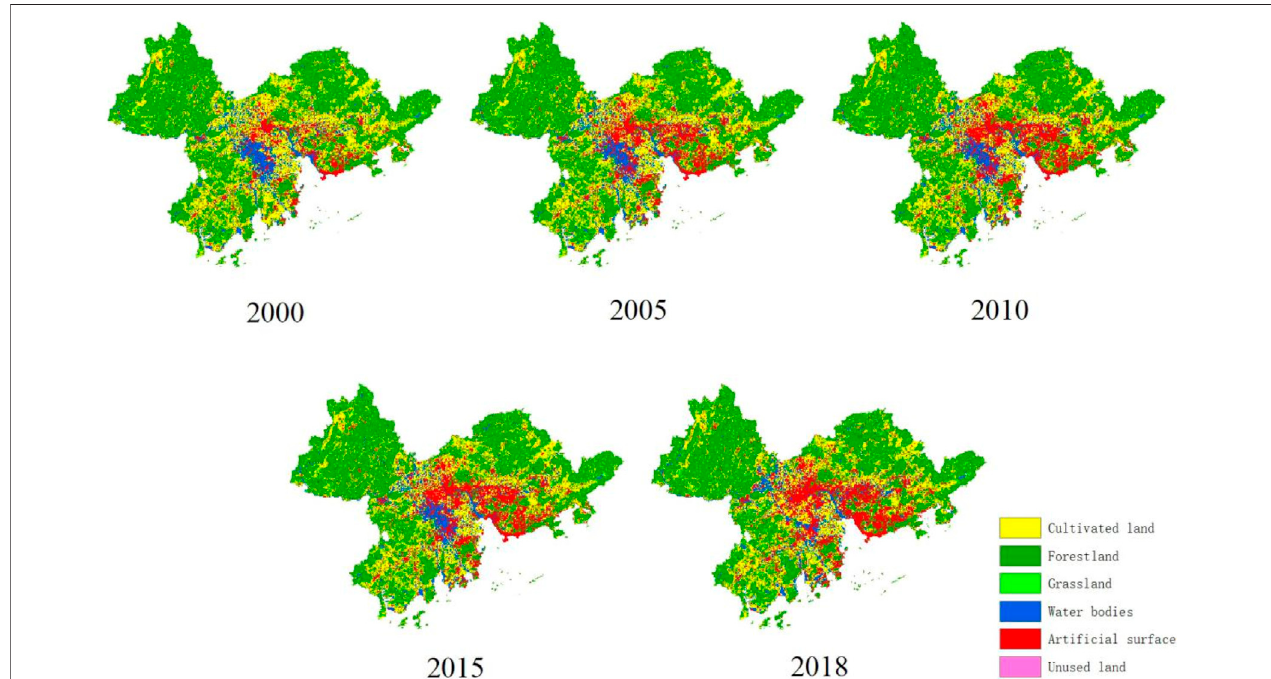
FIGURE 4 | Land use change trend in the Pearl River Delta from 2000 to 2018.